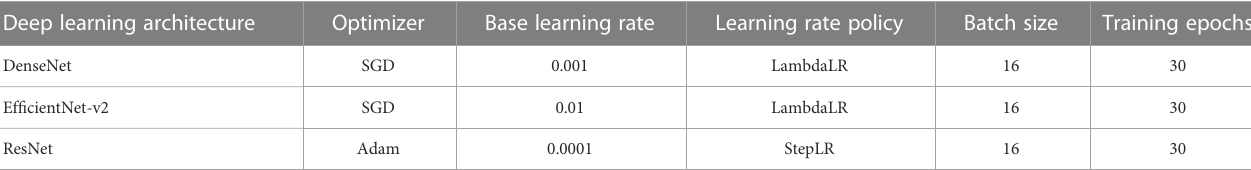
TABLE 2 Hyperparameters used for training the convolutional neural